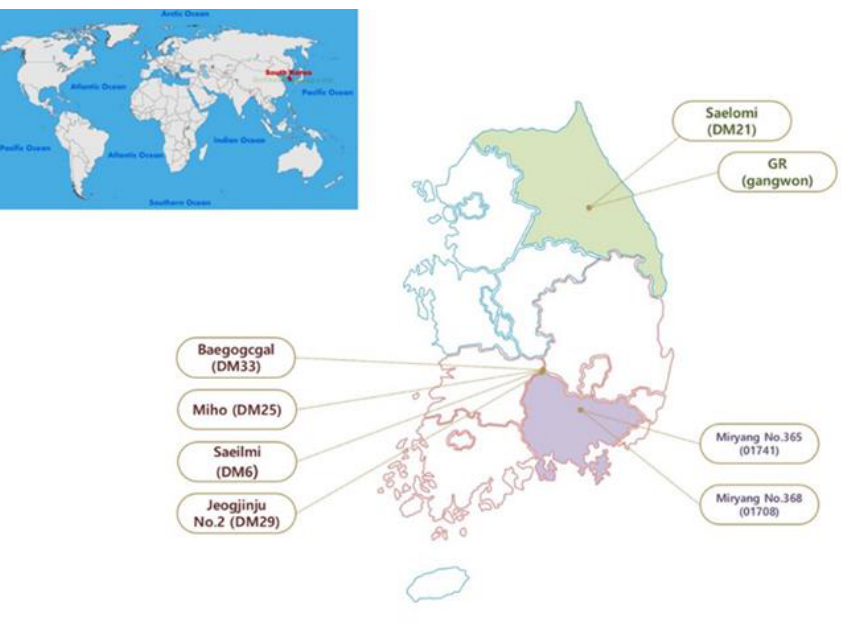
Figure 1. The geographical location of tested rice varieties collected from different areas of South